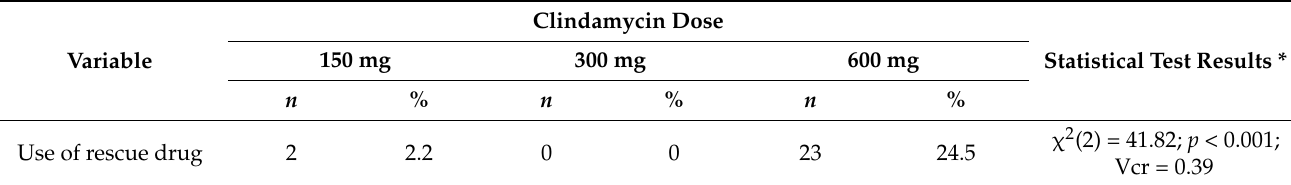
Table 8. Use of rescue drug in the study